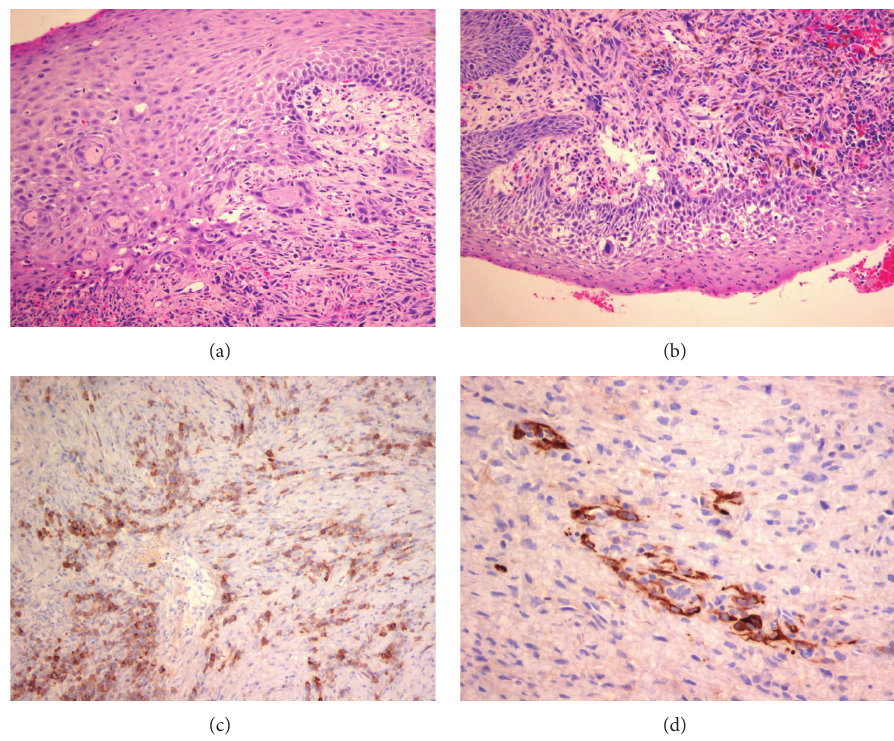
Figure 1: Definitive histological examination showing a carcinosarcoma with carcinomatous and sarcomatous components. Immunohis- tochemistry with monoclonal antibodies (anticytokeratin CK7, CK 8–18, and CK 5-6) for actin, P63, vimentin, S100, desmin, and EMA (epithelial membrane antigen) has been performed. The tumour showed strong positivity for vimentin, EMA, and focal elements for CK 8–18. (a) Hematoxylin-eosin (20x). “In situ” squamous cell carcinoma with cells infiltrating the subepithelial corium. Lower right: undifferentiated spindle cell carcinoma cells. (b) Hematoxylin-eosin (20x). “In situ” squamous cell carcinoma with atypical cells at the basal layers, a sarcomatous component, and hemosiderin deposits. (c) EMA (20x). Immunohistochemistry: carcinomatous cells with membrane positivity for EMA. (d) CK 8–18 (40x): focal positivity for cytokeratin